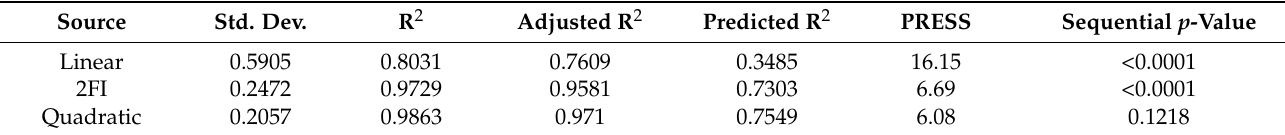
Table 8. Model summary